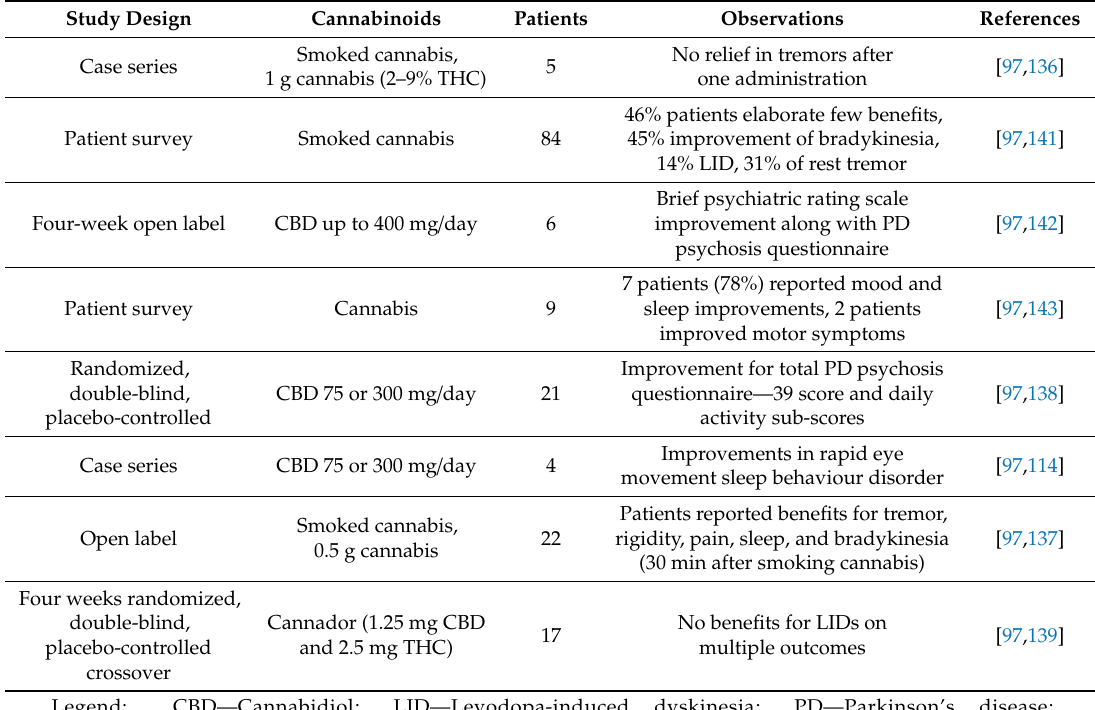
Table 1. Summary of various clinical study designs depicting whether cannabinoids enhance the motor or / and non-motor